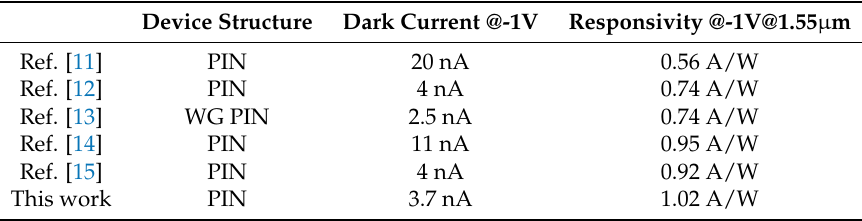
Figure 6. Device performance test results. ( a ) PD spectral response curve. ( b ) PD quantum efficiency curve. ( c ) Photo response current with different incident light powers. ( d ) PD response curve. ( e ) PD response time. ( f ) PD I–V characteristics. Table 1. Comparison of different PIN